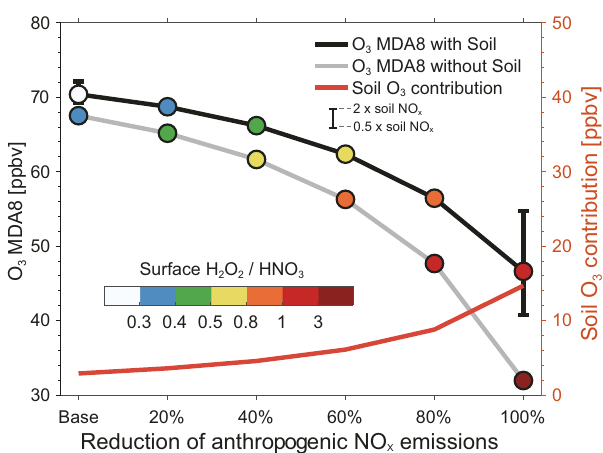
Fig. 3 The presence of soil NO x emissions suppresses the sensitivity of ozone to anthropogenic NO x emissions. The GEOS-Chem simulated responses of MDA8 ozone in the NCP to the decline of anthropogenic NO x emissions by 20, 40, 60, 80, and 100% relative to July 2017 levels (left y -axis), in the presence (black line) and absence (gray line) of soil NO emissions. The black bars represent the range of estimates with a factor of 2 uncertainty in soil NO x emissions. The colored circles represent the mean surface H 2 O 2 /HNO 3 ratios for each emission scenario. The red line (right y - axis) shows the corresponding ozone contribution from soil NO x emissions as can also be estimated from the difference between the black and gray